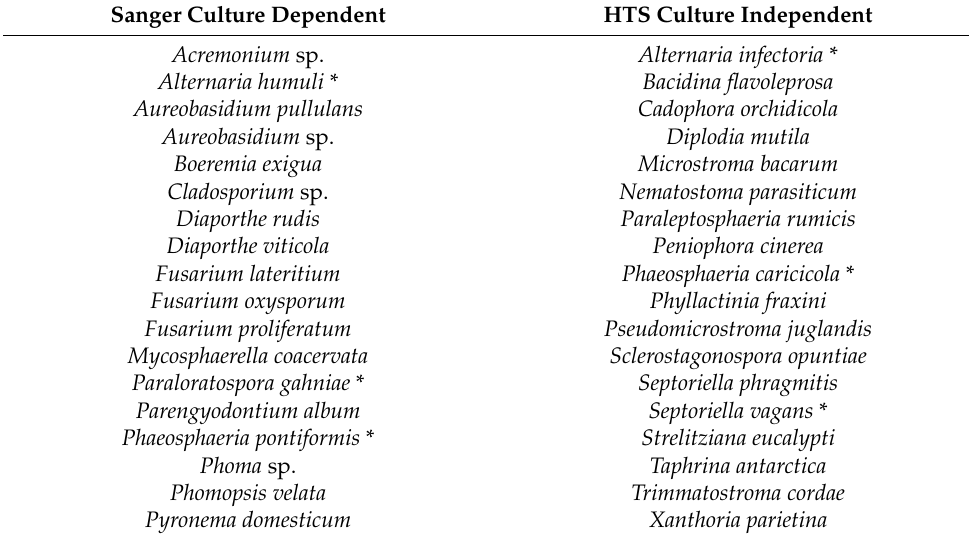
Table 1. Core taxa found at both Roosky and Glasnevin obtained from Sanger sequencing of the isolates or by HTS of leaf samples using nrITS